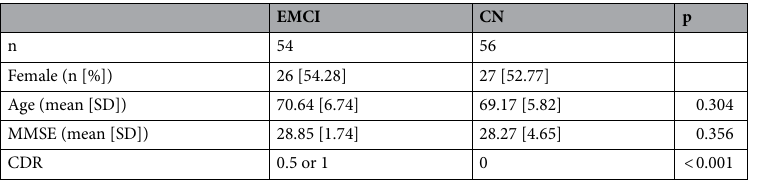
Table 3. Demographics of the participants. CDR clinical dementia rating, MMSE mini-mental state exam, CN cognitively normal, EMCI early mild cognitive impairment.